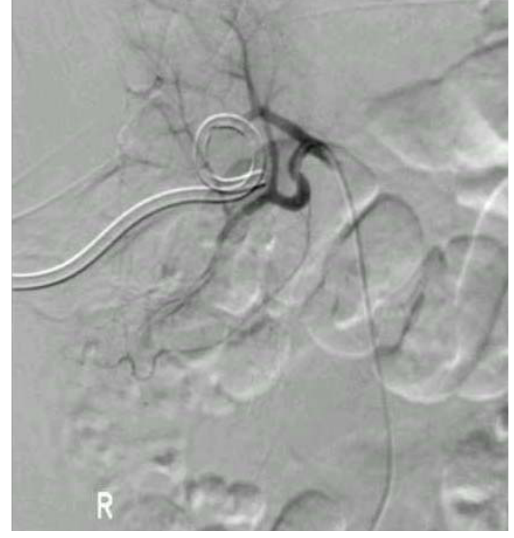
FIGURE 3. Post embolization film demonstrating the disappearance of the pseudo aneurysm. Vascular supply to the upper and lower pole was